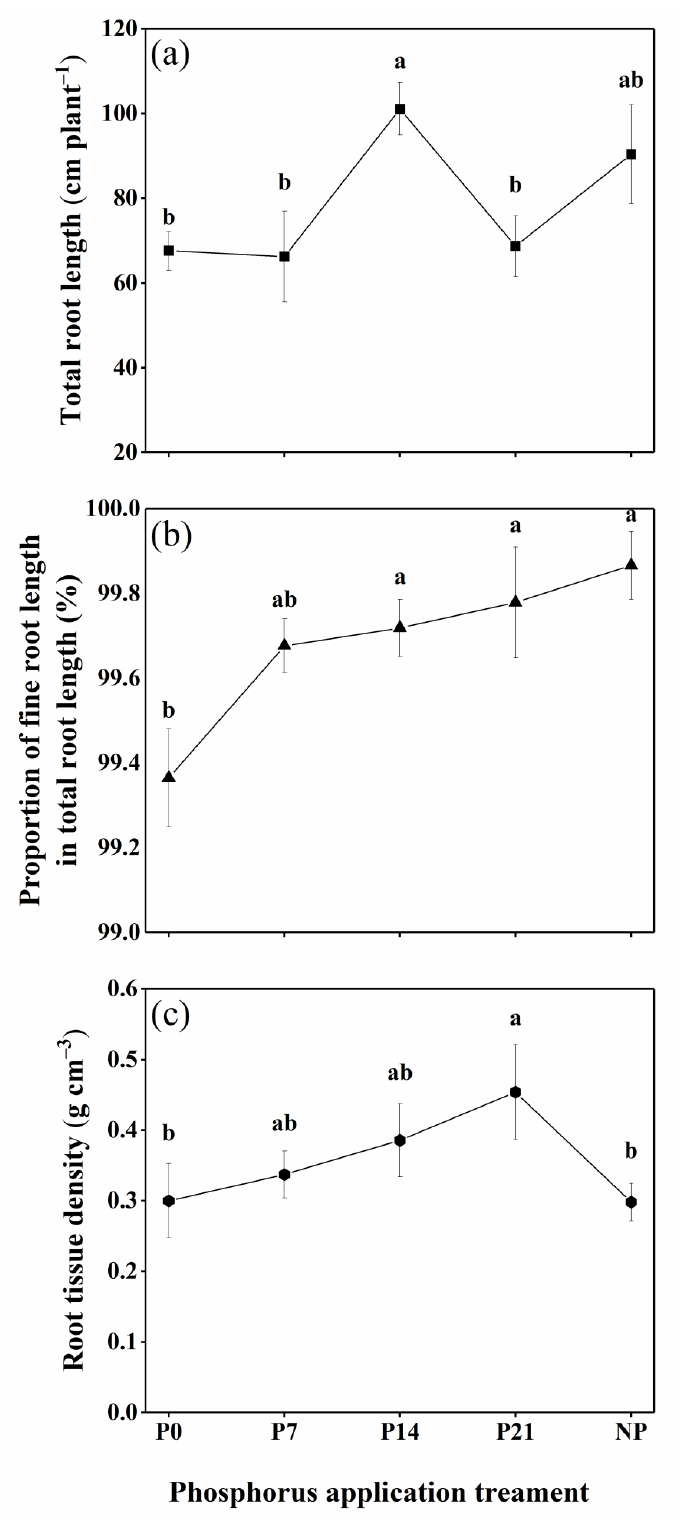
2 Figure 2. Root morphology as a function of P application time: ( a ) total root length (TRL); ( b ) the proportion of fine roots (diameter 0–2 mm) in total root length (PFRL), and ( c ) root tissue density (RTD). P0 means P application at planting; P7 means P application at 7 d after planting; P14 means P application at 14 d after planting; P21 means P application at 21 d after planting; and NP means no P application. Different lowercase letters mean significant differences in TRL, PFRL, and RTD among different treatments at p < 0.05, n =